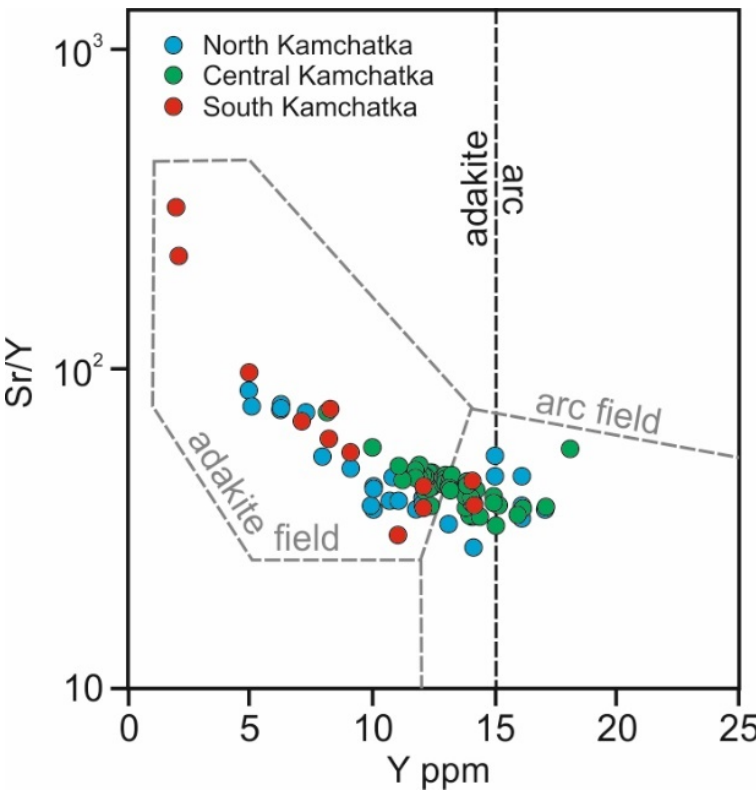
Figure 7. Variations of Sr/Y versus Y (ppm) in adakites and associated volcanic rocks from Kamchatka. Data sources: North Kamchatka [38,45,52], Central Kamchatka [174–176], South Kamchatka [52,177]. Adakites within the northern segment of the Kamchatka volcanic arc were generated via the dehydration melting of garnet amphibolite in the young (<15 Ma) subducted Komandorsky Basin oceanic crust [38,50,52]. Based on their high-Mg character and presence of adakitic veinlets (Sr/Y > 200) in ultramafic xenoliths from the Valovayam volcanic field [58], North Kamchatka adakites interacted extensively with mantle wedge peridotite upon their ascent to the surface [45,50,57,58]. Adakites in central Kamchatka appear to be products of the melting of the tectonically torn, old (Mesozoic) Pacific slab “warmed up” by the intense flow of hot mantle along its edge in a major transoceanic transform fault environment [124]. Mantle xenoliths brought up in modern explosive products of the northern Kamchatka